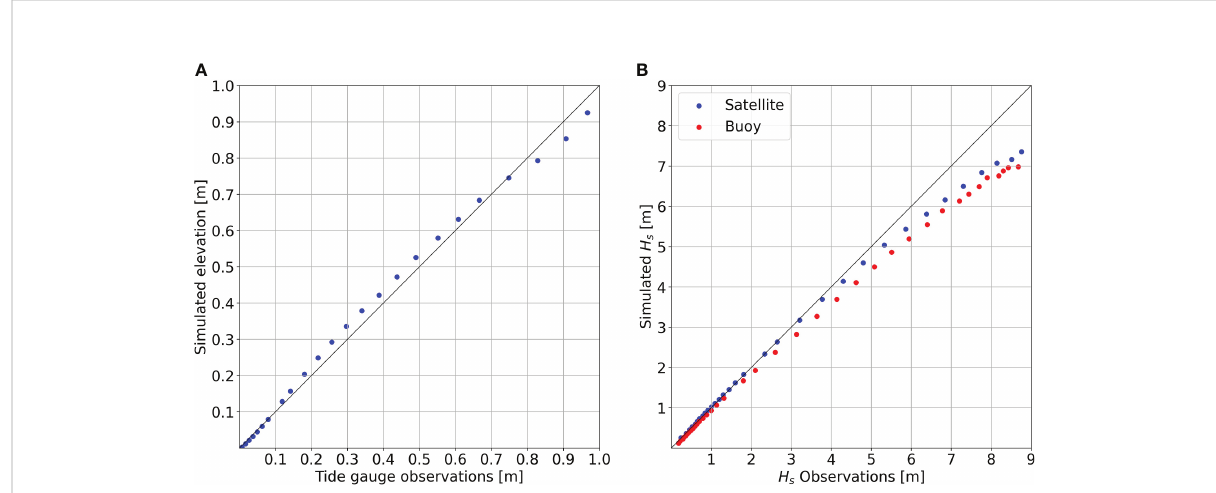
FIGURE 5 Quantile-quantile plot for sea surface elevation and H S . Left (A) panel compares simulated elevation with tide gauges observations. Right (B) panel compares simulated H S to both satellite (blue) and buoy (red) observations. Quantiles are fi rstly equally spaced with an 5 increment from 5 th to 95 th . For higher quantiles, the increment is divided by two at each iteration.